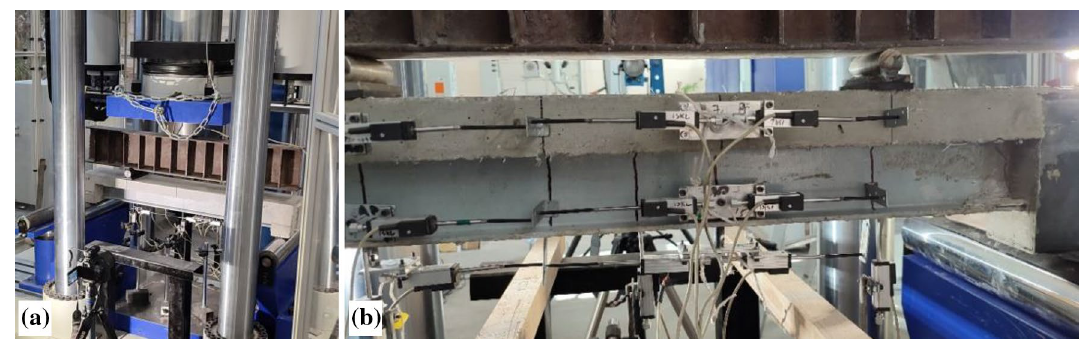
Figure 5. Examples of the bending test setup of the hybrid beam: ( a ) the surface exposed for digital image correlation; ( b ) distribution of linear variable displacement transducers, monitoring vertical and horizontal